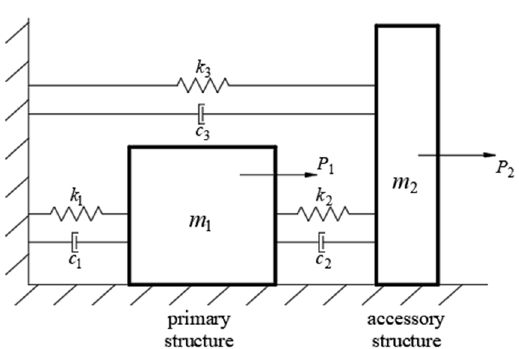
Figure 7. The modified two-degrees-of-freedom theoretical model for the guide wall: the associated- forced coupled vibration (AFCV) system.